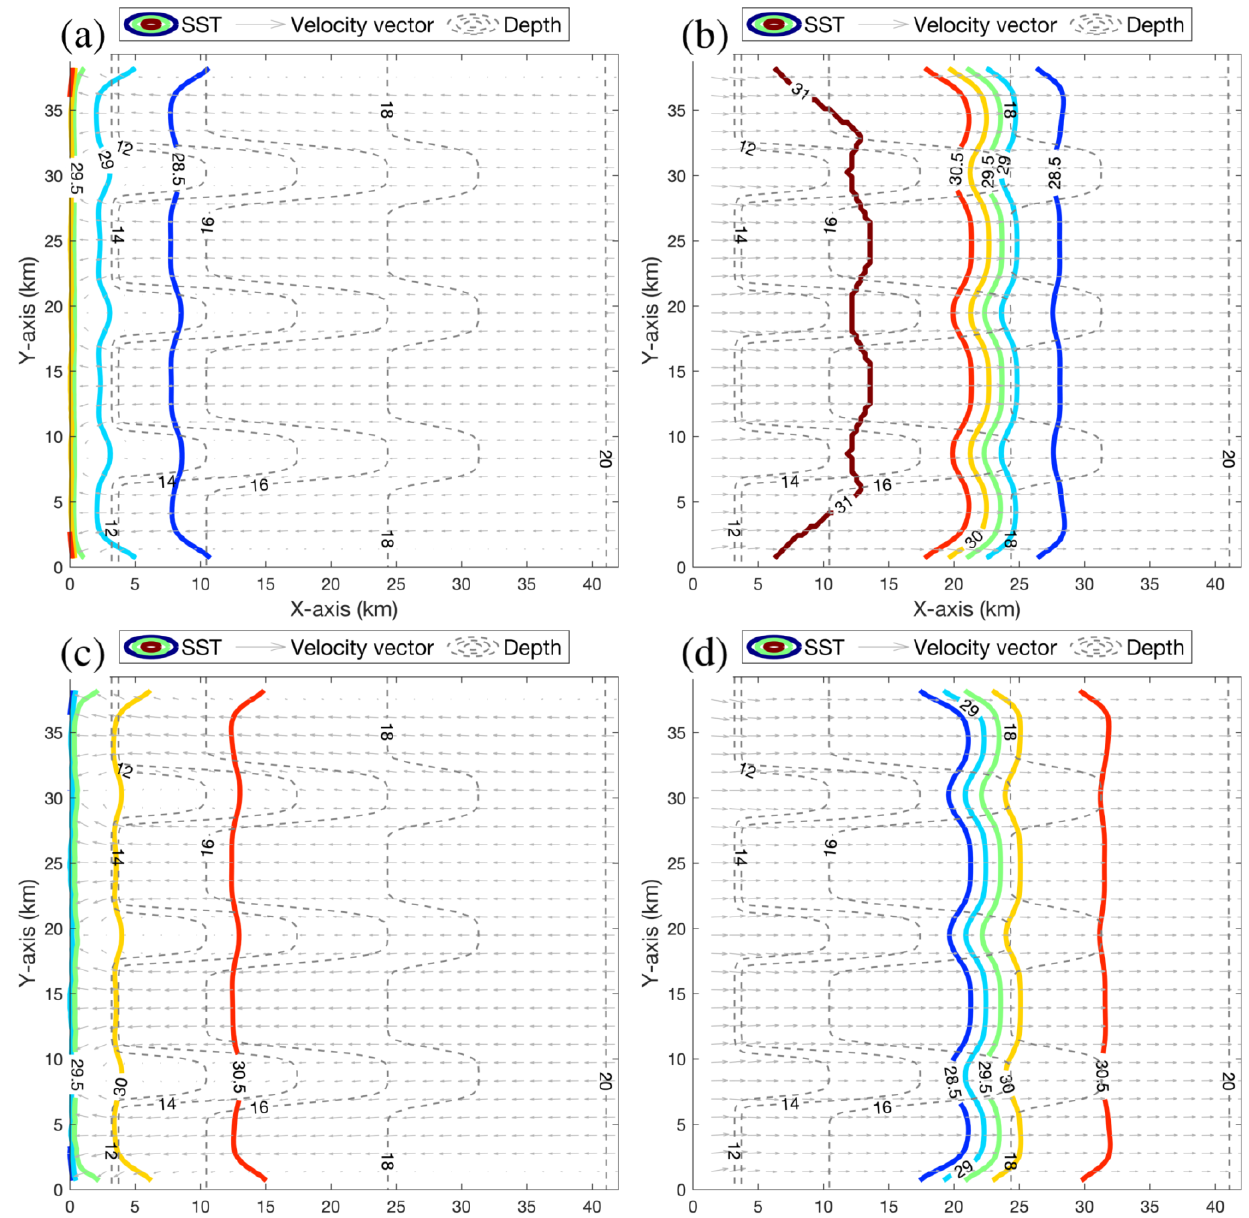
Figure 13. SST distribution (colored contours) at the end of westward ( a ) and eastward ( b ) current simulated by EXP_ID1. ( c , d ) are the same as ( a , b ), respectively, but show results of EXP_ID2. Gray vectors display the surface current, while dashed-gray lines show the water depth.